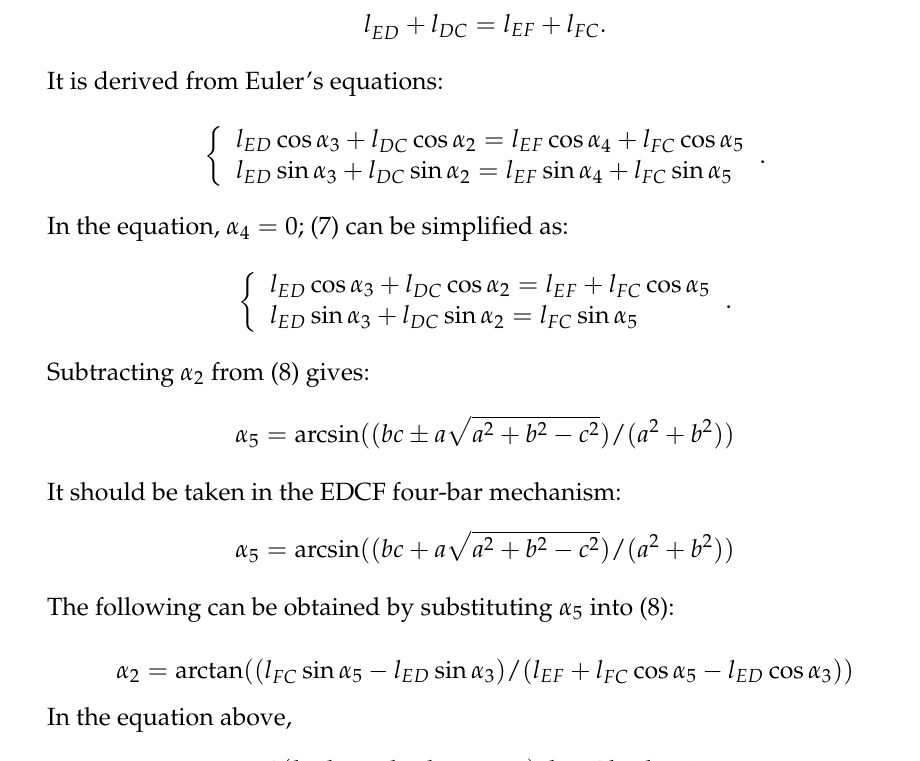
Figure 5. Schematic diagram of the equivalent mechanism of the second configuration. For four-bar mechanism EDCF, the cartesian coordinate system is established with node E as the origin and rod l EF as the X-axis, and the vector equation can be obtained: